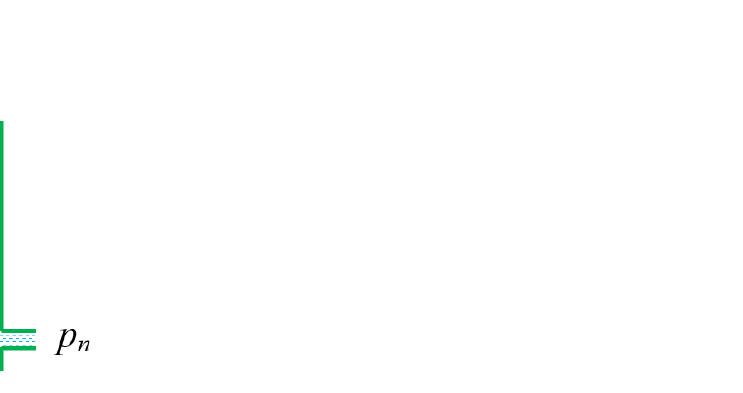
Figure 3. Sketch of the linear water tank describing the interception process, for a maximum water volume stored on the canopy, S (mm), corresponding to the interception capacity.